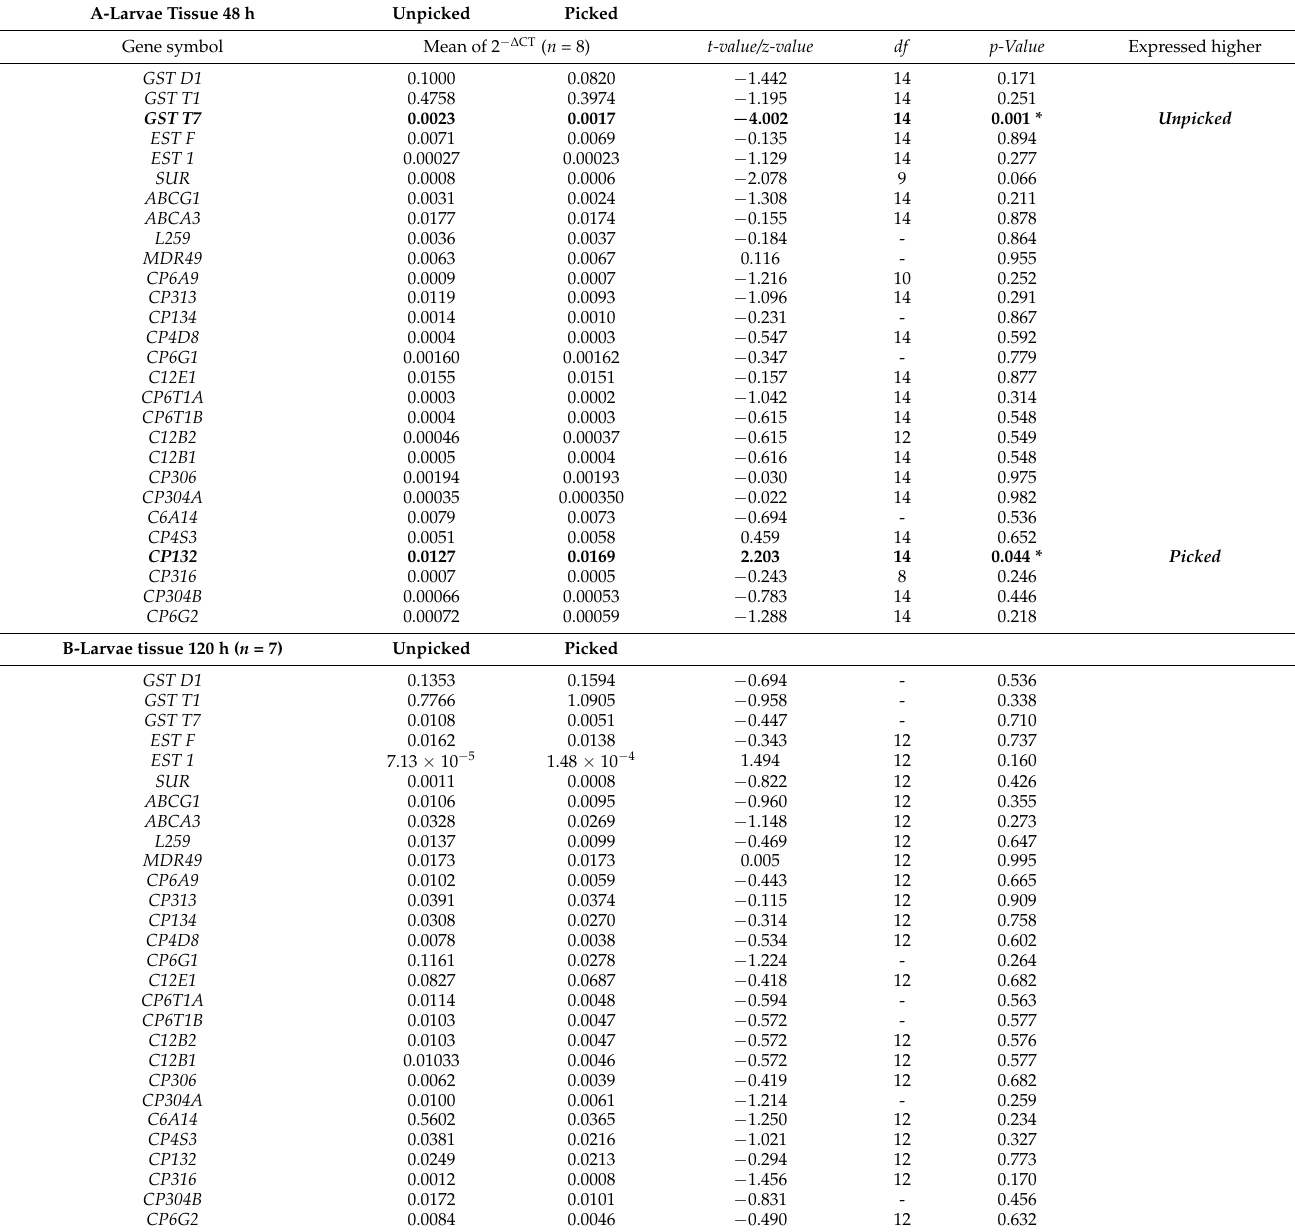
Table 5. Statistical analysis results of differential gene expression in Bactrocera tryoni larvae reared in unpicked or picked colour-break Roma tomato fruit and collected in 48 h and 120 h after inoculation (when larvae were approximately in their 1st and 2nd instars). The comparative analyses were performed between the following: (A) gene expression from tissue of larvae sampled from unpicked versus picked tomato fruit 48 h after larval inoculation; (B) gene expression from tissue of larvae sampled from unpicked versus picked tomato fruit 120 h after larval inoculation; (C) gene expression from tissue of larvae sampled from unpicked tomato fruit 48 h versus 120 h after larval inoculation; and (D) gene expression from tissue of larvae sampled from picked tomato fruit 48 h versus 120 h after larval inoculation. Analyses were unpaired t -test or Mann–Whitney U test, depending on the error distribution of the data. The 28 selected genes are associated with insect detoxification pathways and are as follows: (1) cytochrome P450 ( CP6A9, CP313, CP134, CP4D8, CP6G1, C12E1, CP6T1A,